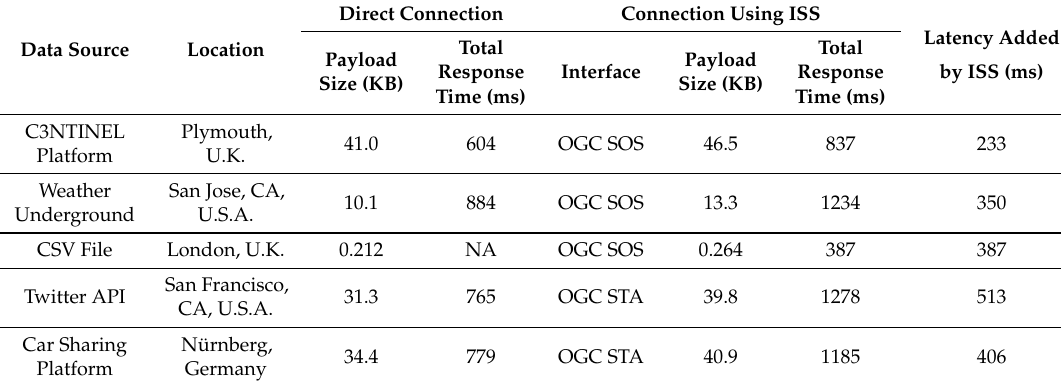
Table 2. Comparison between the original payload sizes and total response times when directly querying the different platforms and when querying using a standardized interface with the help of the InterSensor Service. The payload sizes and total response times shown are average of five requests that were made against each platform for the time ranges as shown in Figures 9–11. The InterSensor Sensor Service and OGC web client applications mentioned in this paper are hosted at servers located in the Technical University of Munich, Germany. Locations of the hosted platforms mentioned in the table are determined using